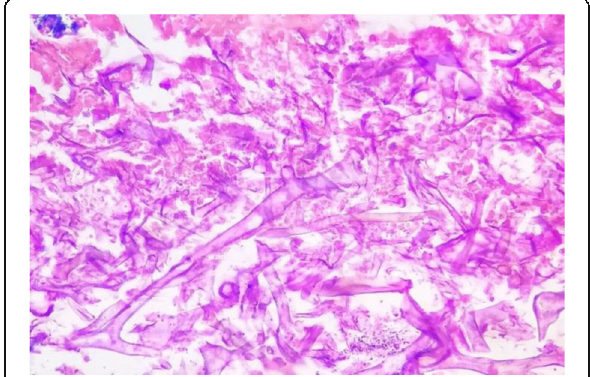
Fig. 2 Histopathology smear from right maxillary sinus showing broad nonseptate hyphae of